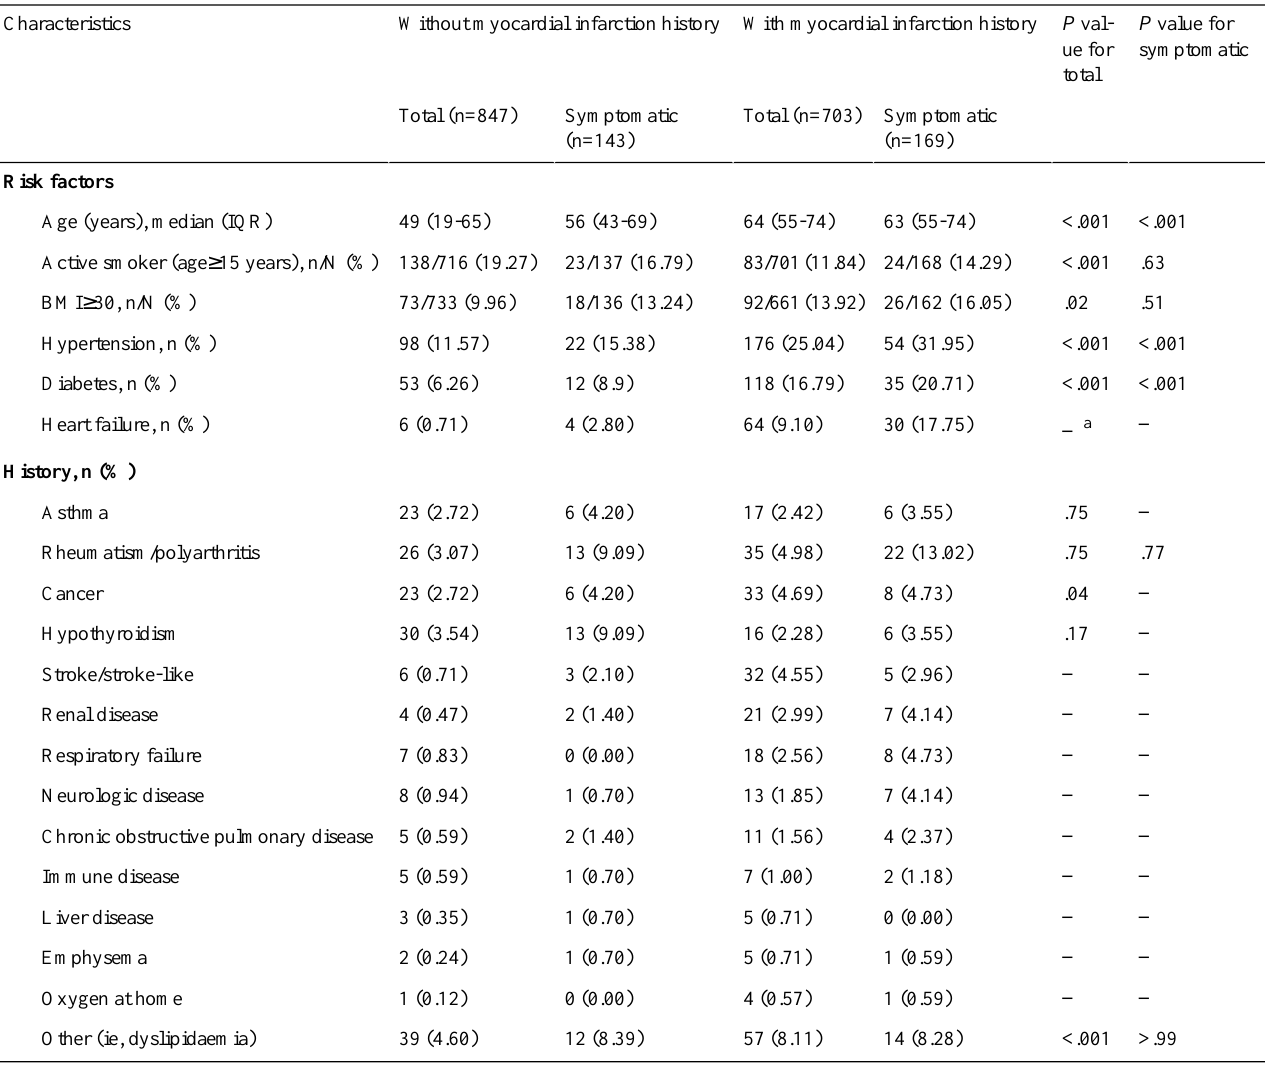
Table 1. Risk factors and history of the 1552 included individuals with and without myocardial infarction history (two missing